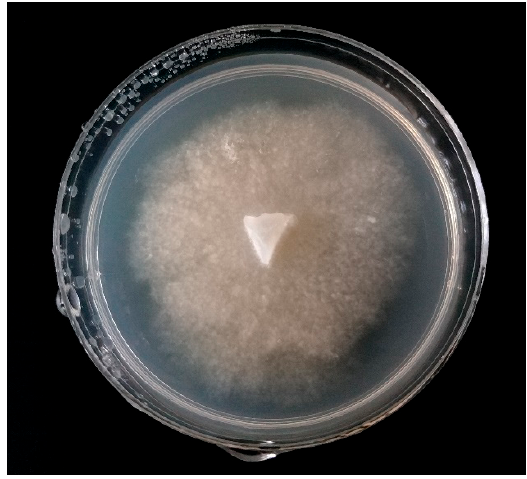
Figure 2. Phytophthora sp. isolated on PDA medium from ecological strawberry plantation after 10 days of incubation in 22 °C.